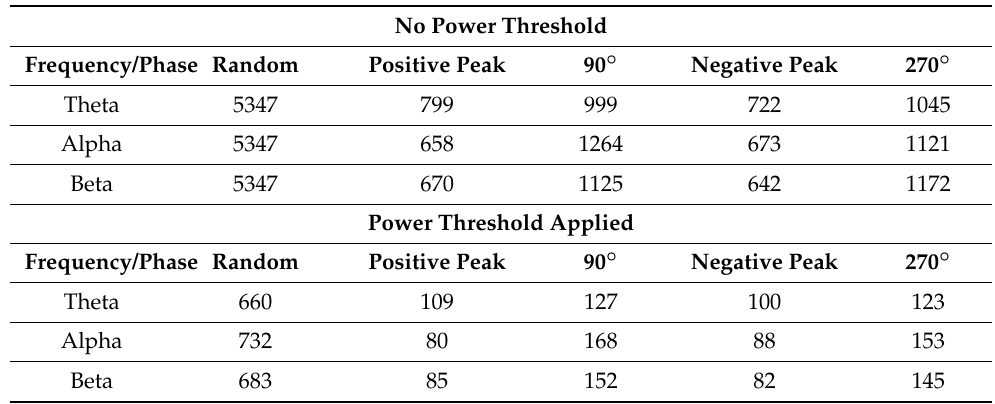
Table 2. Total number of trials in each phase category before and after applying the power threshold (mean of power for each frequency band and every